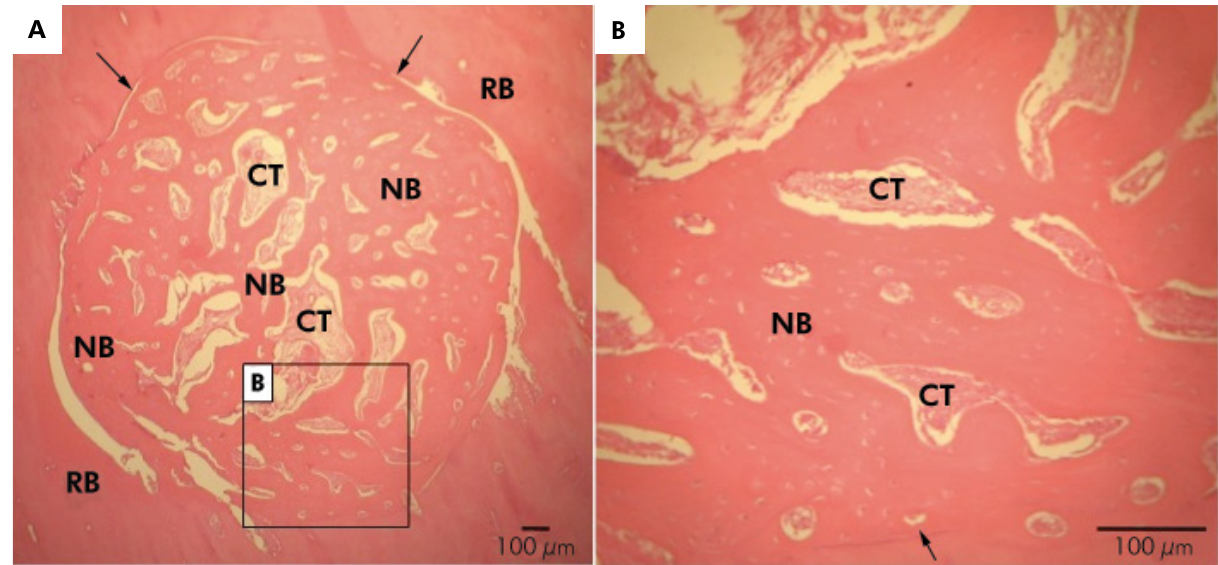
Figure 3. Representative photomicrographs of the control group. Defect area (black arrow); newly formed bone (NB) composed of wide anastomosing trabecular bone adjacent to remaining bone (RB). The central portion of the defect shows areas of connective tissue (CT). Stain: hematoxylin and